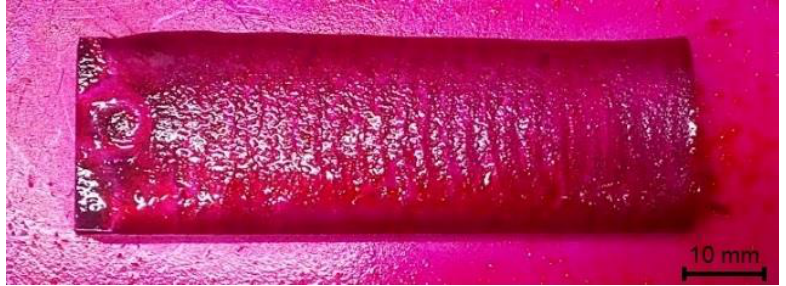
Figure 4. View of the sample during the penetrant testing (PT).